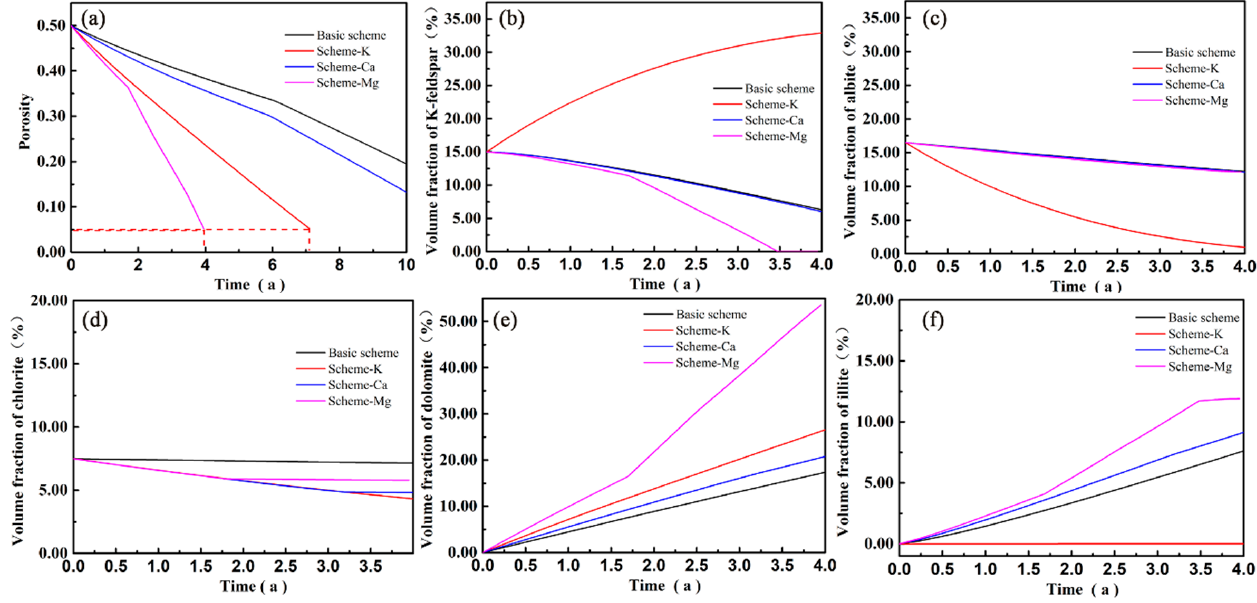
15 of 18 Figure 10. Simulation results at different injection temperatures. ( a )—Porosity; ( b )—Permeability; ( c )—Dolomite; ( d )—Illite. 5.3.3. Influence of Different Hydrochemical Compositions Figure 11 shows the simulation results of different chemical composition schemes of injected water under an injection flow rate of 5 m 3 /h and an injection temperature of 70 °C. Compared to the basic scheme, the porosity at the injection point in different chemical